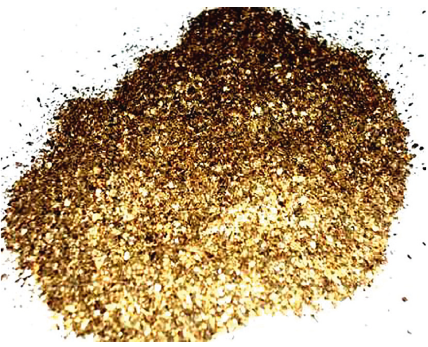
Figure 3: Photo of vermiculite